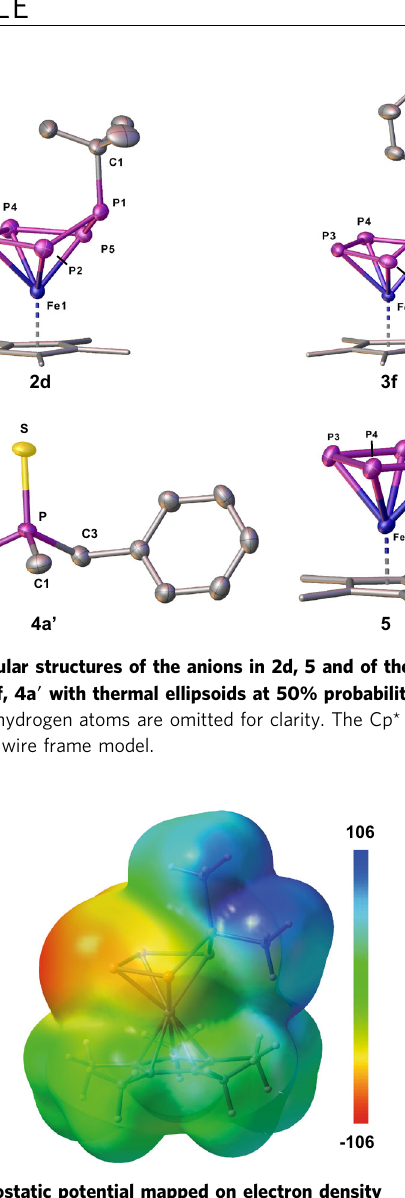
(Supplementary Fig. 39). The lithium derivative of 5 can be detected in all reactions of 3b-e with organolithium reagents but decomposes partly over time in solution.